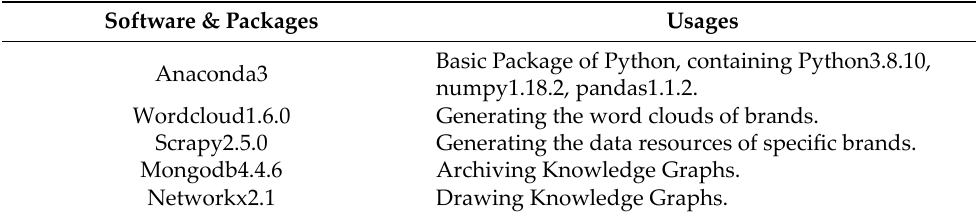
Table 4. Software and libraries for deploying NEL.